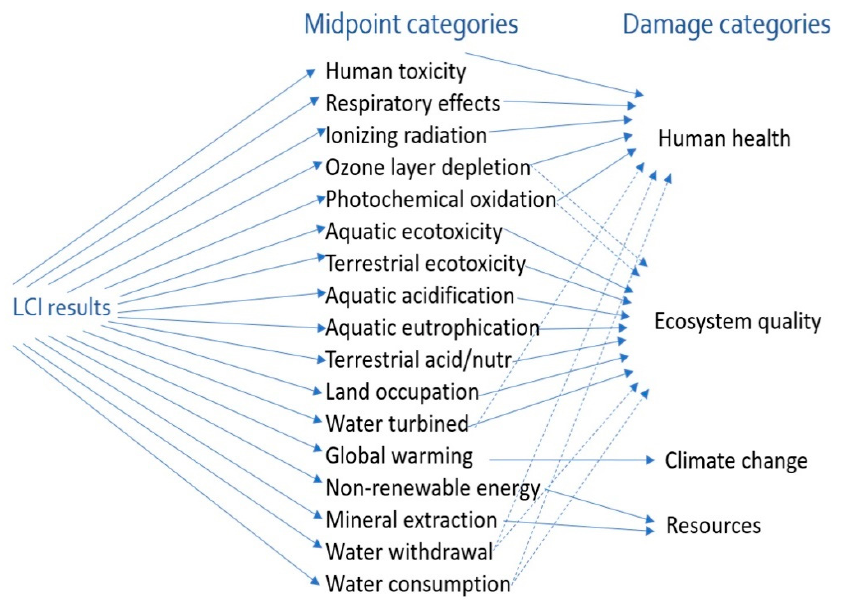
Figure 4. Mid- and end-point environmental impact categories assessed [91]. LCI, life cycle inventory.